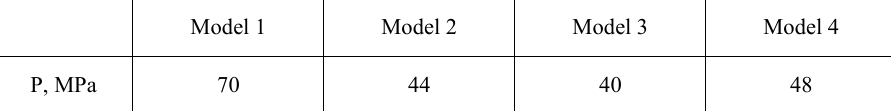
Table 1. The pressure values in the gelatin layer for all the models .